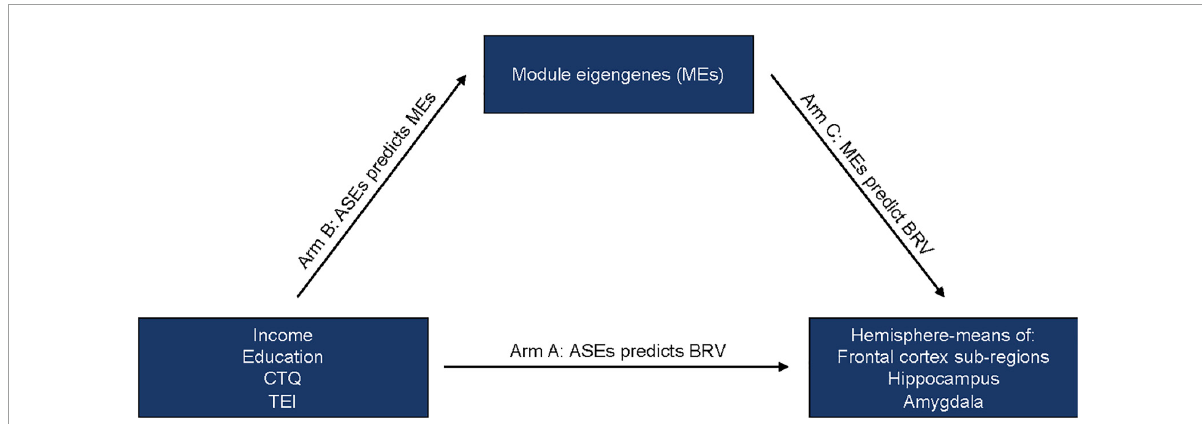
FIGURE1 Conceptual model testing individual module eigengenes (MEs) as mediators of the hypothesized associations between adverse social exposures (ASEs) and variability in fronto-limbic brain morphometries. Arm A: Analyses included average hippocampus and amygdala volumes as dependent variables (in separate models). Income, education, CTQ total, and TEI were included as independent variables of interest, whereas genomic ancestry, age, employment/disability and ICV were included as covariates. The same predictors and covariates were included, minus ICV, to predict frontal cortex subregions SA and CT measures. Arm B: Analyses included 5mC MEs as dependent variables (in separate models). Income, education, CTQ total, and TEI were included as independent variables of interest, and employment/disability was included as a covariate. Arm C: Analyses included individual fronto-limbic morphometry measures as dependent variables (in separate models). Individual 5mC MEs were included as independent variables of interest, whereas age, genomic ancestry, employment, and ICV (ICV was only included in hippocampus and amygdala models) were included as